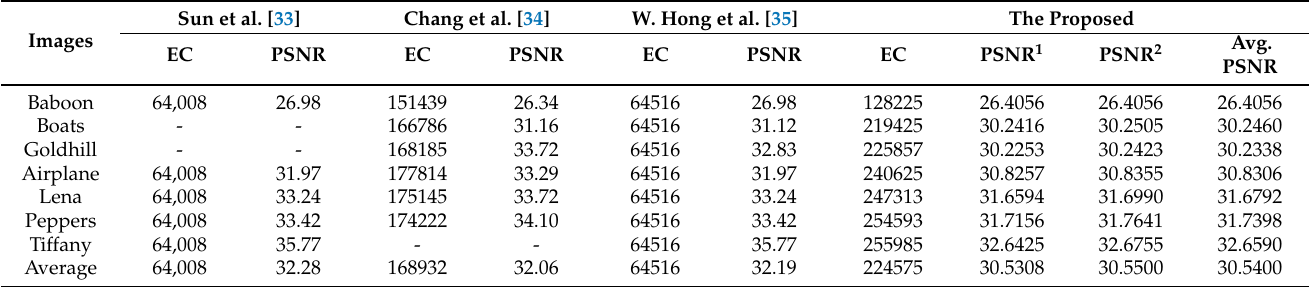
Table 3. Comparing the maximum EC and PSNR of the existing method and our proposed method.